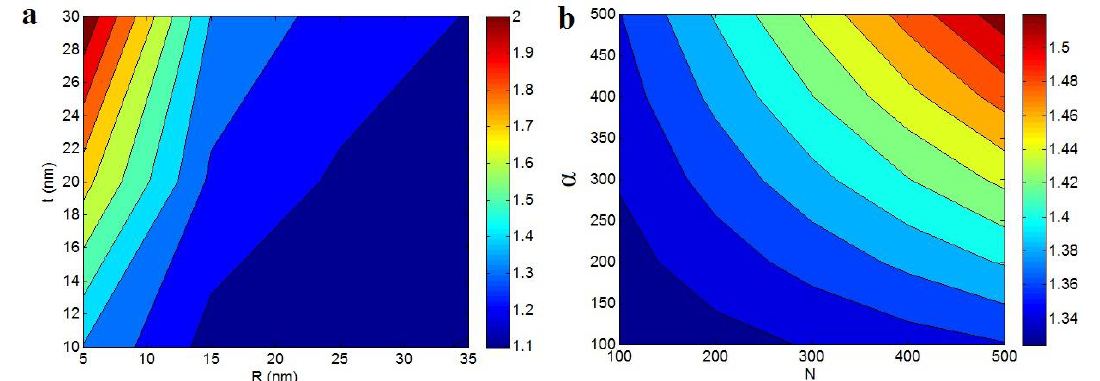
 = 0.02, σ m = 40 MPa, f = 0.02, σ = 40 MPa, R  = 0.02, σ m f m = 40 MPa, R = f